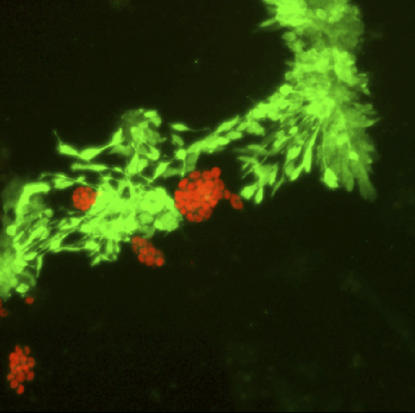
Neural progenitors (green) were efficiently generated from embryonic stem cells (red) through activation of the Notch pathway.